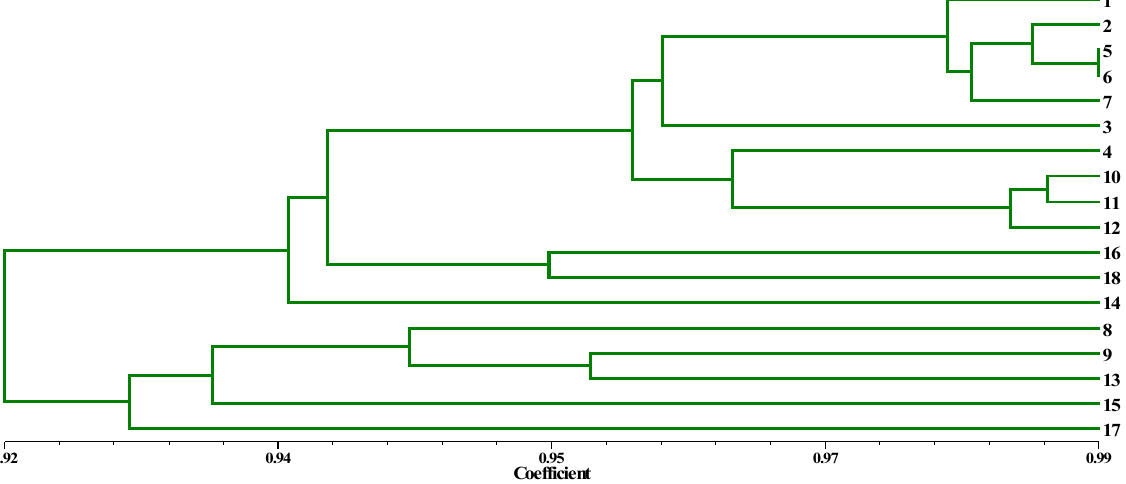
Figure 1. Dendrogram obtained from UPGMA (Unweighted Pair-Group Method with Arithmetic mean) cluster analysis using the Dice coefficient.